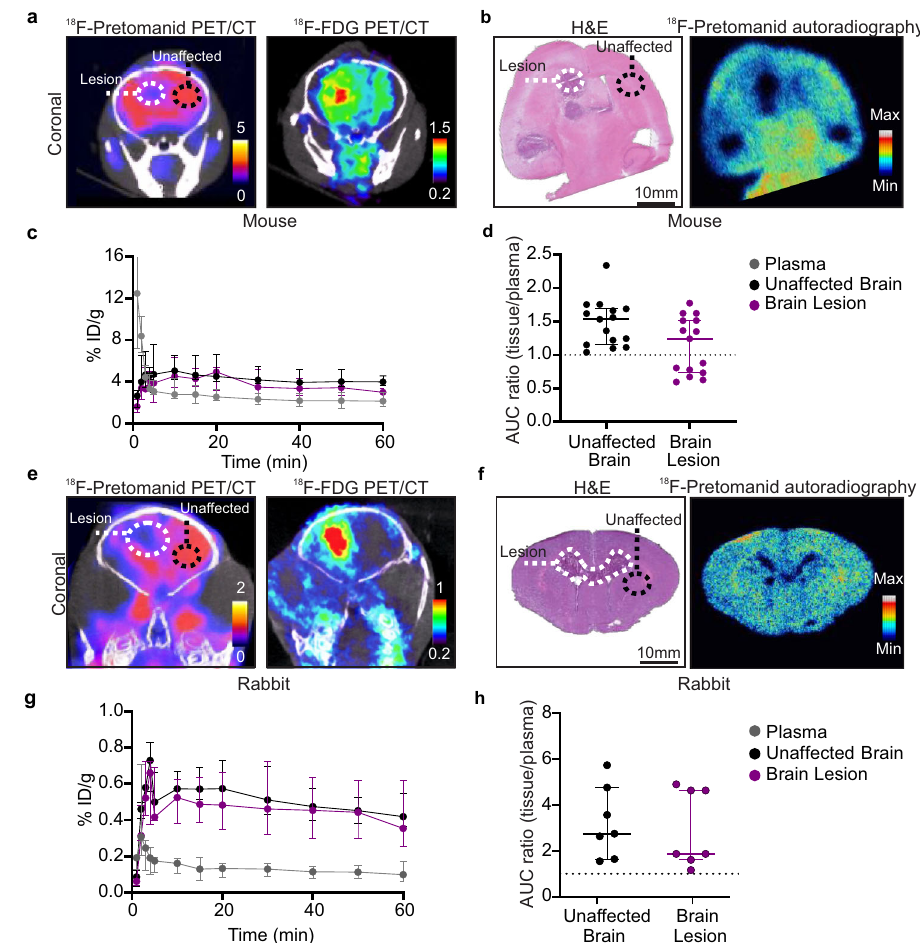
Fig. 3 | Brain penetration of 18 F-pretomanid in mouse and rabbit models of TB meningitis.a – d Mice, n =8. a Coronal 18 F-pretomanidand 18 F-FDGPET/CTshowing the brain lesion and unaffected brain. b Histopathology and 18 F-pretomanid auto- radiographyofthesamemousebrainshowingbrainlesions(whitedottedline)and unaffectedbrain(blackdottedline). c Time-activitycurves(TACs)from0to60min forplasma,brainlesionsandunaffectedbrain. d Areaunderthecurve(AUC)ratios (tissue/plasma) in unaffected brain [ n =15 volume of interests (VOIs)] and brain lesion ( n =15 VOIs) ( P =0.055). Each dot represents a VOI. e – h Rabbits, n =4. e Coronal 18 F-pretomanid and 18 F-FDG PET/CT in the same rabbit. f Histopathology